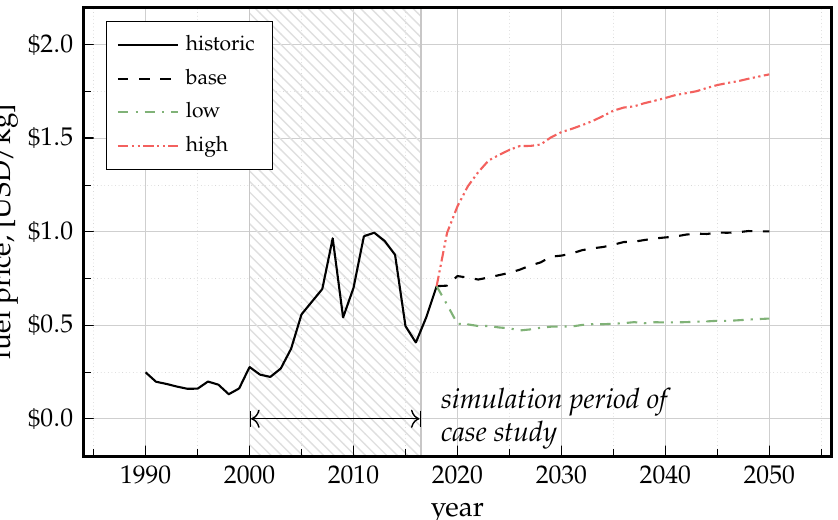
Figure 9. Implemented fuel price scenarios based on US Gulf Coast kerosene-type jet fuel spot price, taken from the US Energy Information Administration